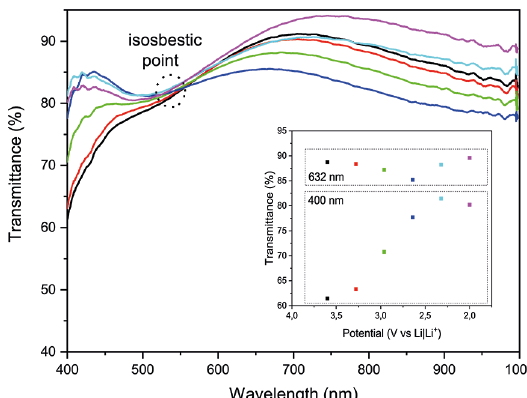
Figure 6. Voltammograms for V thicknesses, showed the phases transitions.